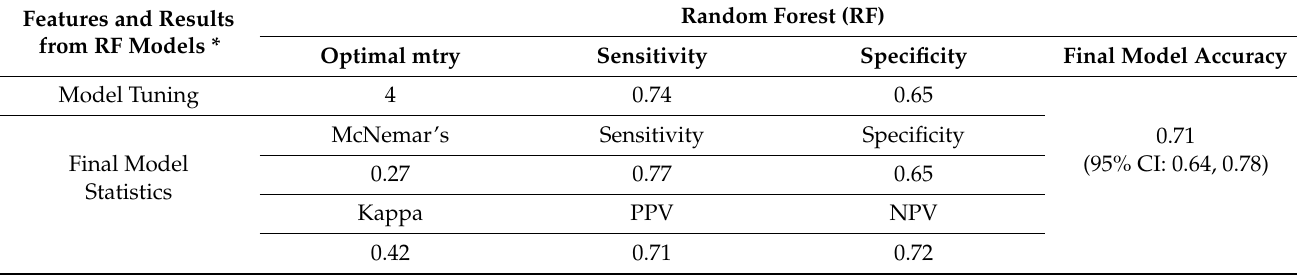
Table 2. Predictive statistical and model tuning parameters of the random forest analyses presented in Figure 2, which interrogated serum creatinine-electrolyte + GGT (relative deviation) data for the best predictors of NATA class (High or Low Minor Condition